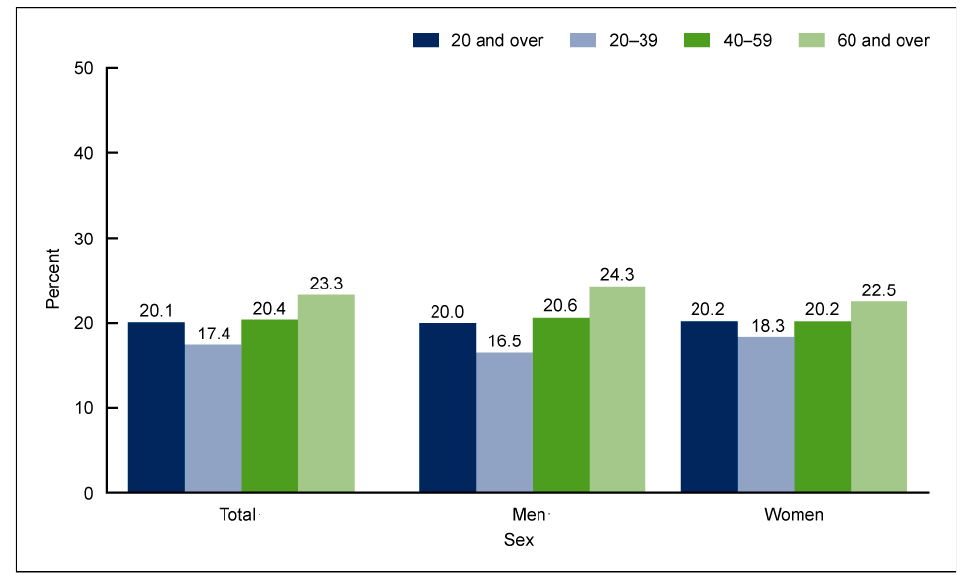
Figure 2. Percentage of adults aged 20 and over consuming seafood at least two times per week, by age and sex, in the United States in 2013–2016 [23].